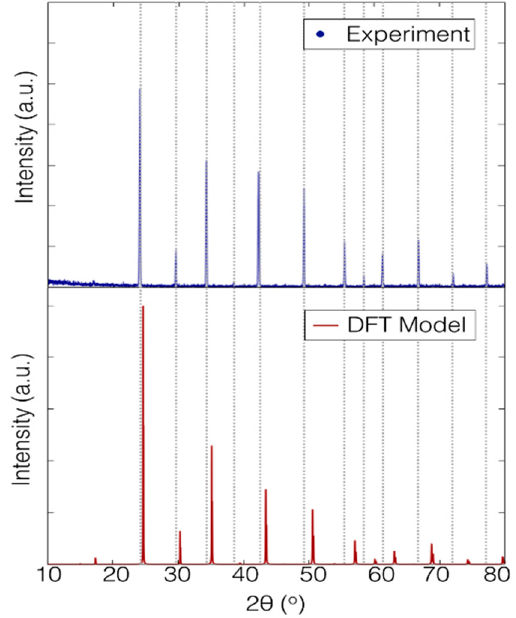
Figure 4. Measured powder XRD pattern for Cs 2 InAgCl 6 ( top ), and the XRD pattern calculated from the atomistic model optimized using density functional theory/local density approximation (DFT/LDA) ( bottom ). Reproduced with permission from Reference [31]. American Chemical Society,